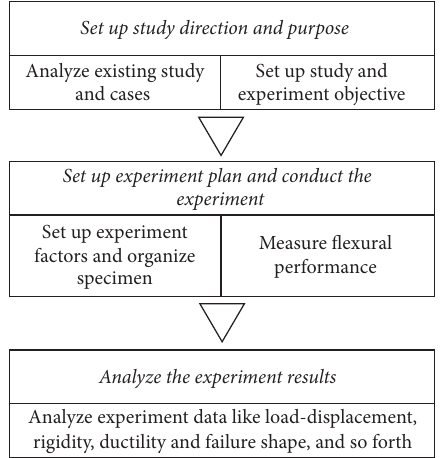
Figure 1: The overall scope and flow of